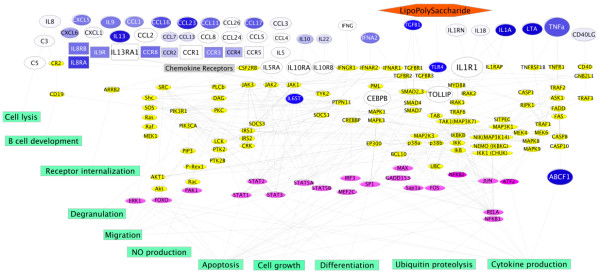
A model of molecular interactions in the odontoblast layer (ODL) of carious teeth. We map the inflammatory signal arising from ODL in response to caries as the network of previously demonstrated protein interactions, downstream from the differentially regulated gene products observed in this study. These activating or inhibitory interactions taken from the STRING and KEGG databases have been demonstrated for the same human proteins in other tissue and cell types. Size and color of node depiction for caries-induced genes in ODL were varied as in Figure 4. Intracellular signaling molecules (yellow) were mapped and linked to the transcription factors (magenta) and the resulting cellular responses (green). The network describes a parts list of component interactions to be assessed in future studies for the mechanistic basis of signal propagation from caries to pulpitis.